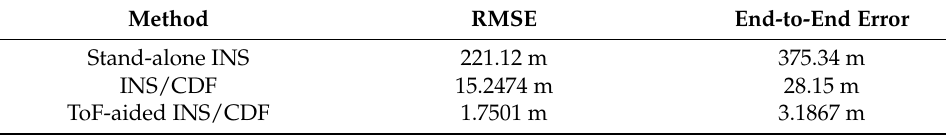
Figure 18. Absolute 2D positioning error. Table 4. The RMSE and the end-to-end 2D position error for scenario 1.